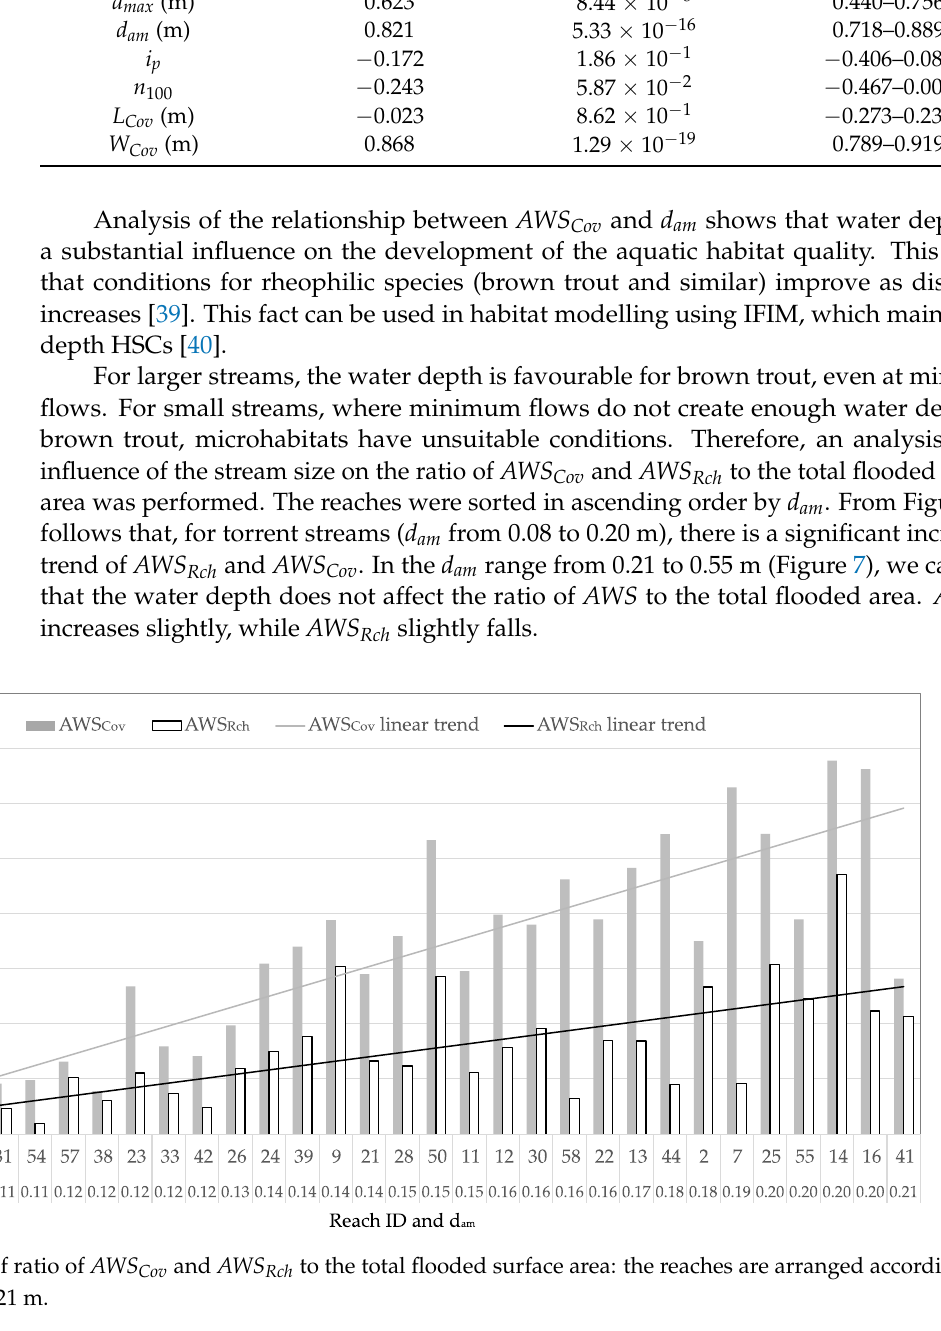
Figure 7. Comparison of the ratio of AWS Cov and AWS Rch to the total flooded surface area: the reaches are arranged accord- ing to d am from 0.21 m to 0.54 m. For d am from 0.35 m to 0.54 m, the trend line is depicted by the grey dashed line ( AWS Cov ) and the black dashed line ( AWS Rch ).